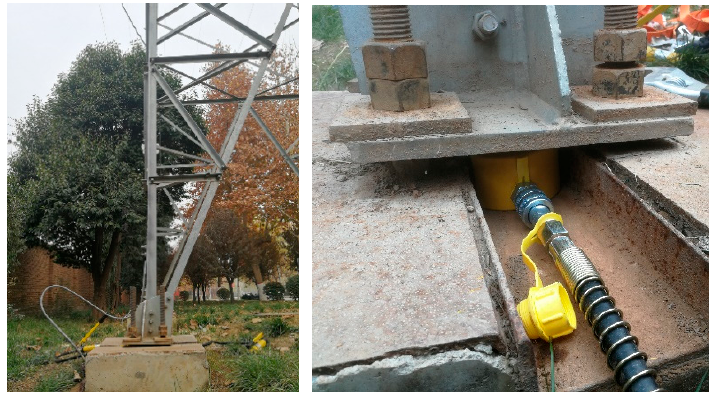
Figure 9. Photo of the experimental setup.